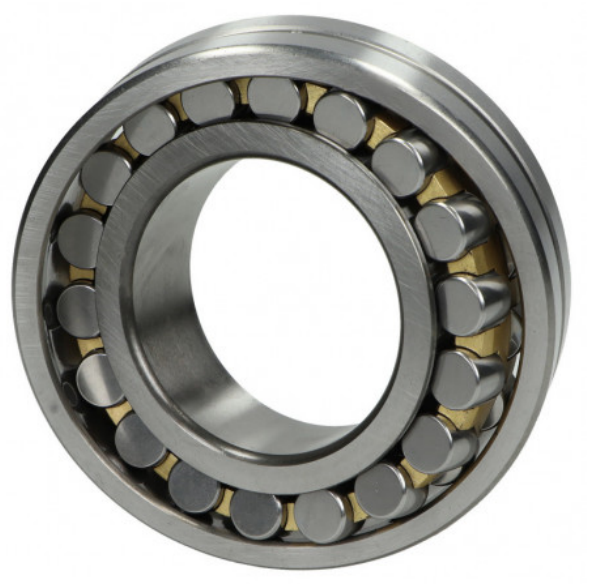
Figure 4. The special series spherical roller bearings (SKF22324VAJ): basic static load—1120 kN; dynamic load—850 kN; and limiting speed—2000 RPM.